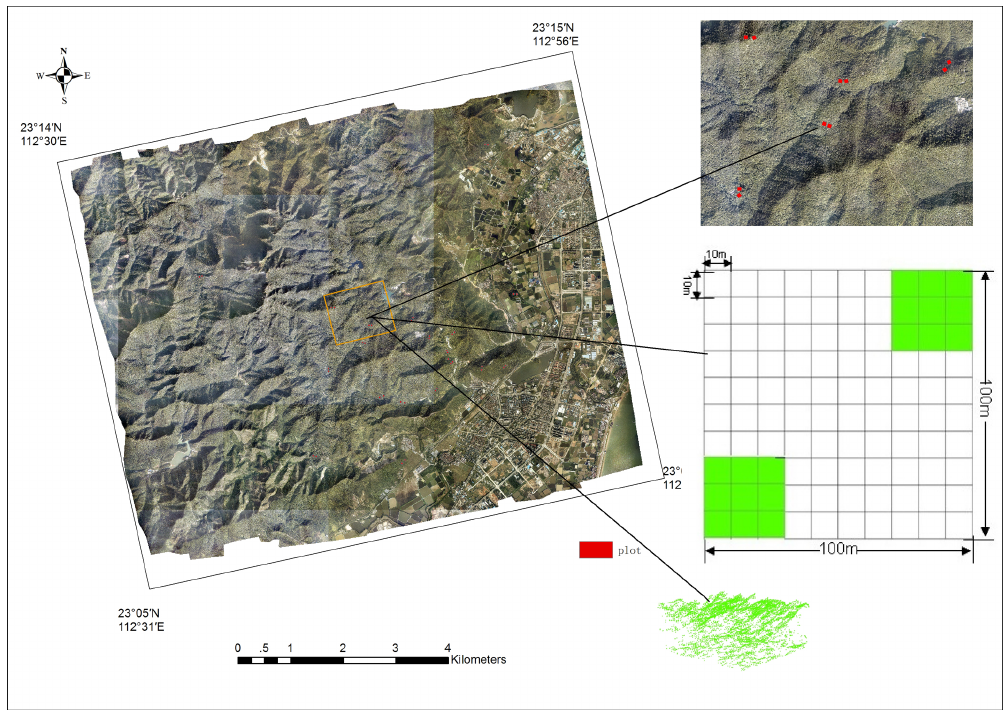
Figure 1. The study zone of Dinghushan National Nature Reserve, Guangdong Province, China. Table 1. Statistics of tree species distribution for 10 forest sample